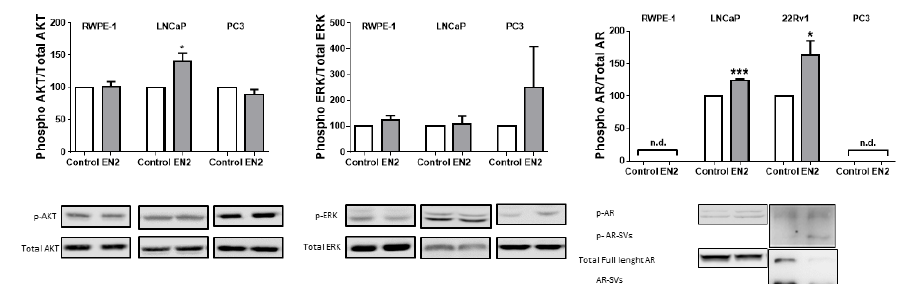
Figure 3. Downstream consequences of EN2 treatment in RWPE-1, LNCaP, 22Rv1, and PC3 cells. Phosphorylation of key signaling pathways (AKT, ERK, and AR; from left to right) after EN2 treatment during 8 min, compared with non-treated control (full western blot images in Figure S6). n.d means non-detectable levels. AR-SVs = AR splice variants. Data represent mean ± SEM and they are expressed as percentage of the ratio (set at 100%). * p ≤ 0.05, *** p < 0.001 indicate significant differences compared to control.